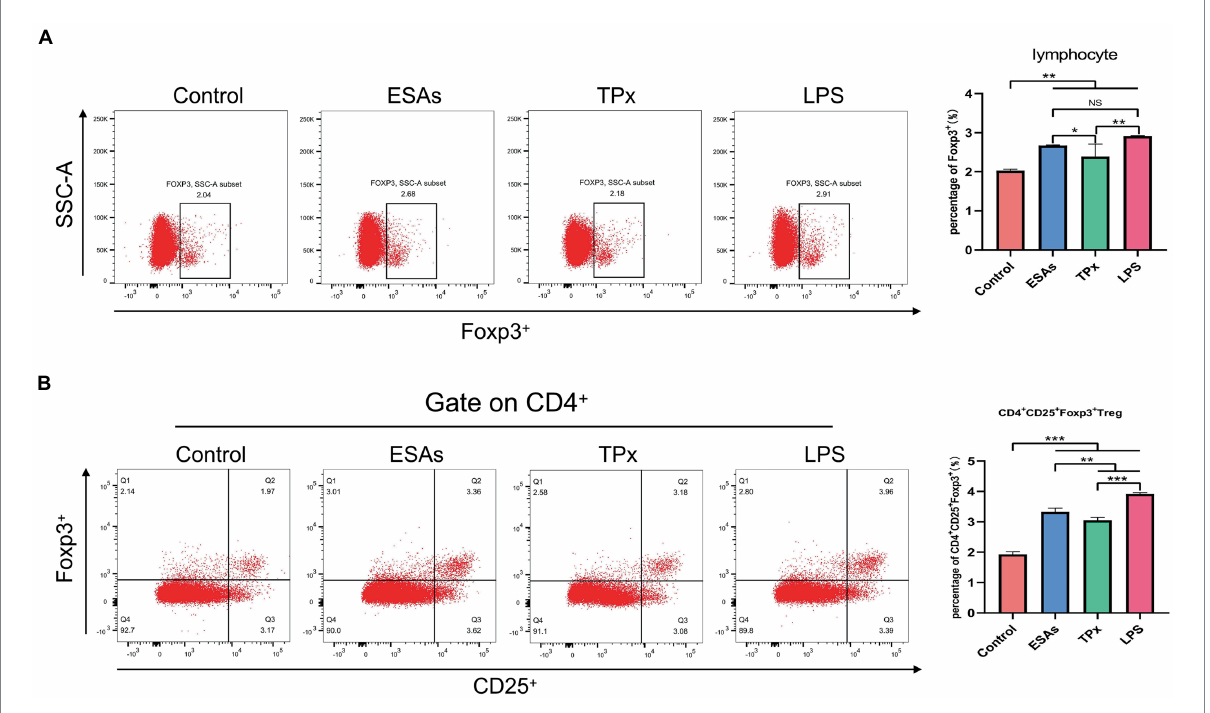
FIGURE 3 Tregs induction assay. (A) C. cellulosae ESAs and TPx significantly induced the expression of Foxp3 + lymphocytes, both of which were statistically significant. (B) C. cellulosae ESAs and TPx caused an increase in the number of CD4 + CD25 + Foxp3 + Tregs in peripheral blood mononuclear cells, and the difference was statistically significant. All data were expressed as the mean ± SD, NS stands for not significant, * p < 0.05, ** p < 0.001, *** p <